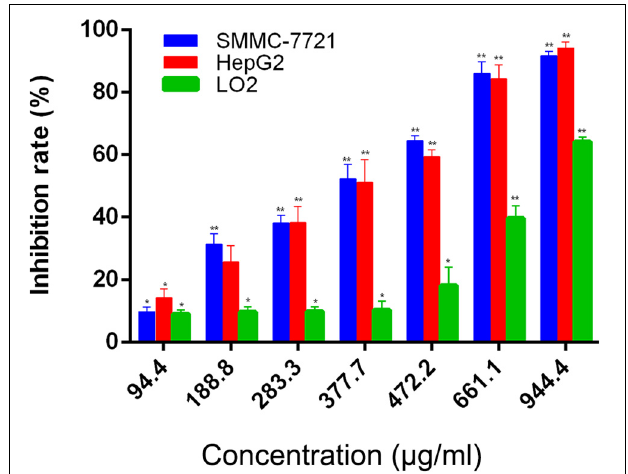
FIGURE 2 | AAEO treatment inhibits cellular proliferation in SMMC-7721 and HepG2 cells. Data are expressed as the mean ± SD of three independent experiments. *p < 0.05 and **p < 0.01 vs. the control group.